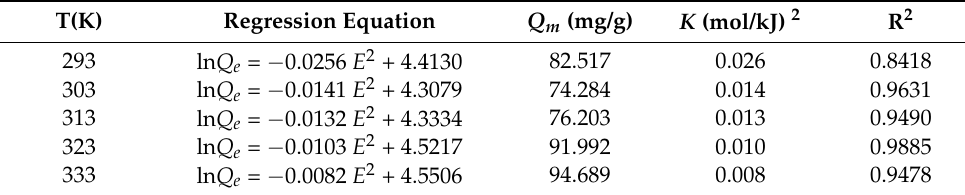
Table 6. D-R constants for methyl orange adsorption onto